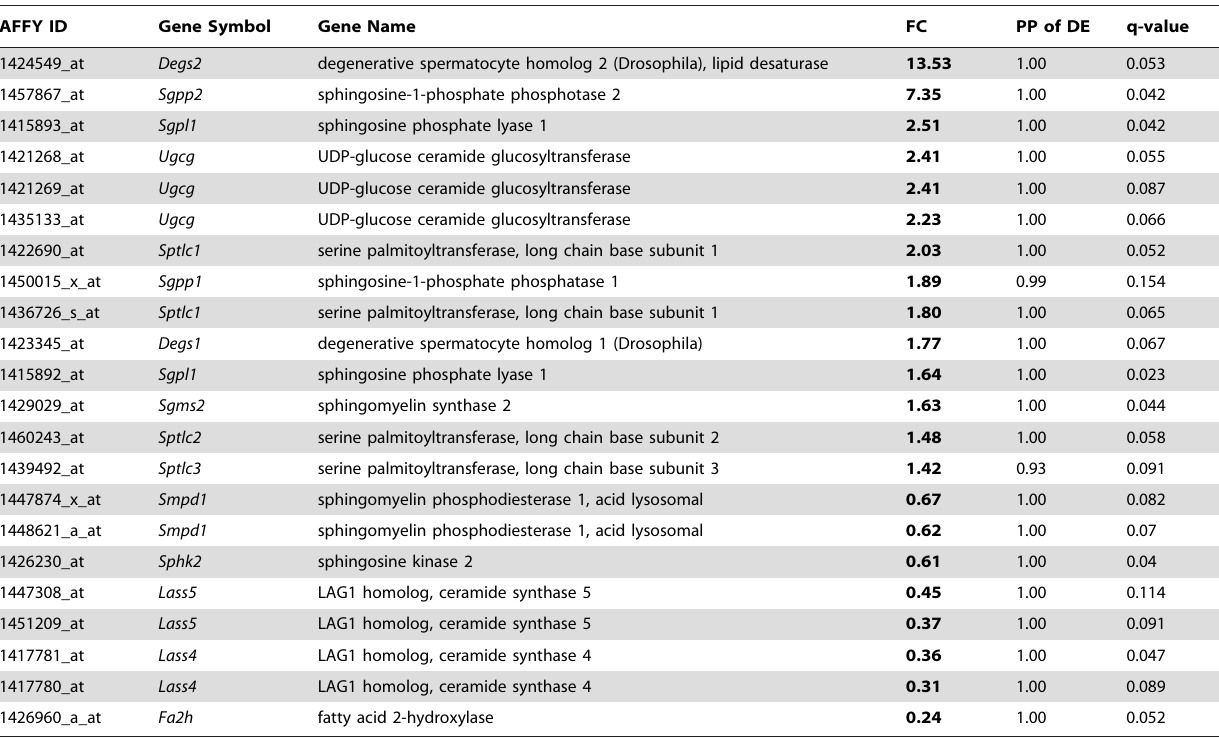
Table 11. Sphingolipid